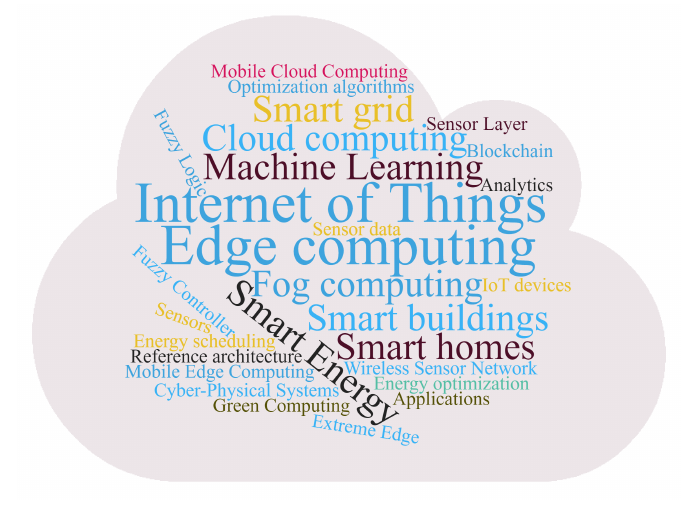
Figure 5. Keyword cloud from the Reviews